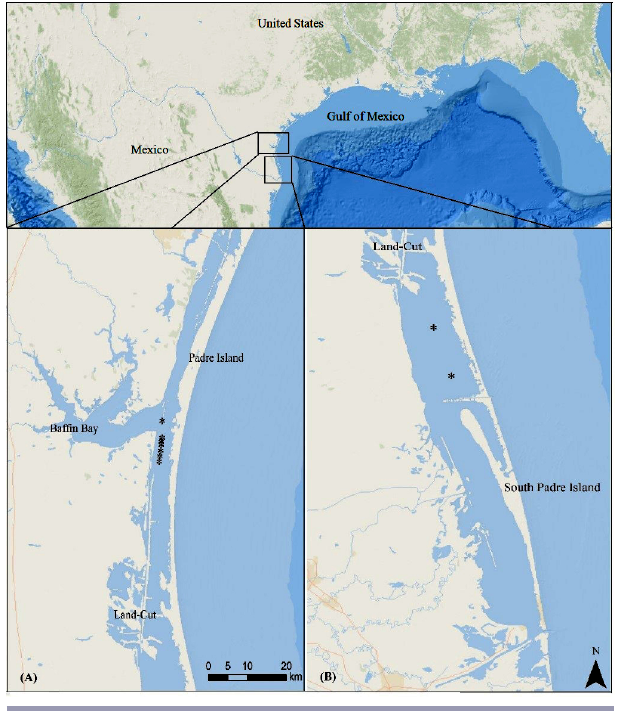
Fig. 1 . Location of seven breeding colonies in the upper (A) and two in the lower (B) Laguna Madre, Texas, where Reddish Egrets ( Egretta rufescens ) were trapped during